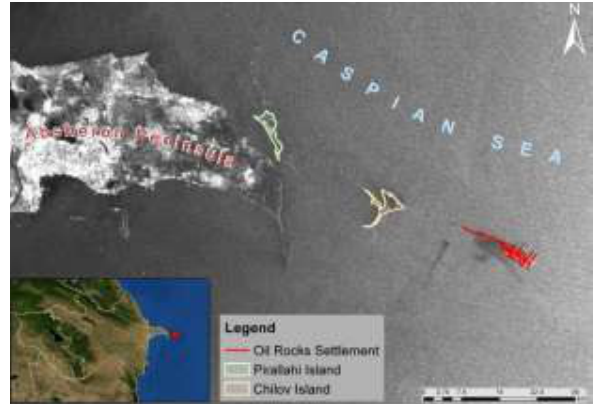
Figure 1. Map of the Oil Rocks Settlement, Pirallahi & Chilov Islands